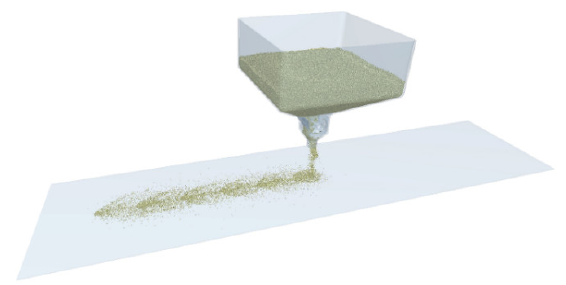
Figure 8. Fertilization simulation process.